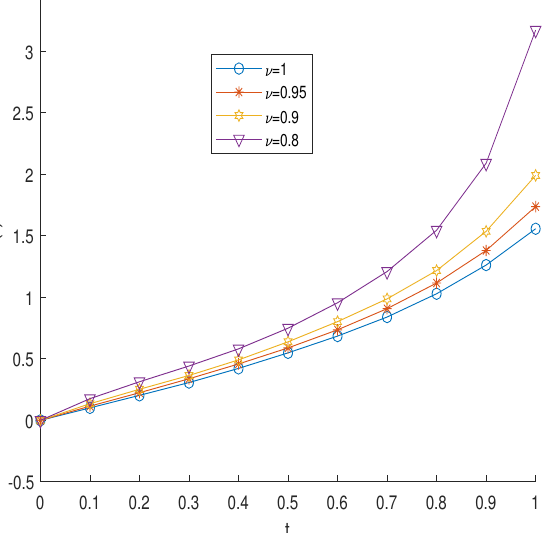
Figure 8. Approximate solutions of x ( t ) for N = 10 with ν = { 0.8,0.9,0.95,1 } for Example